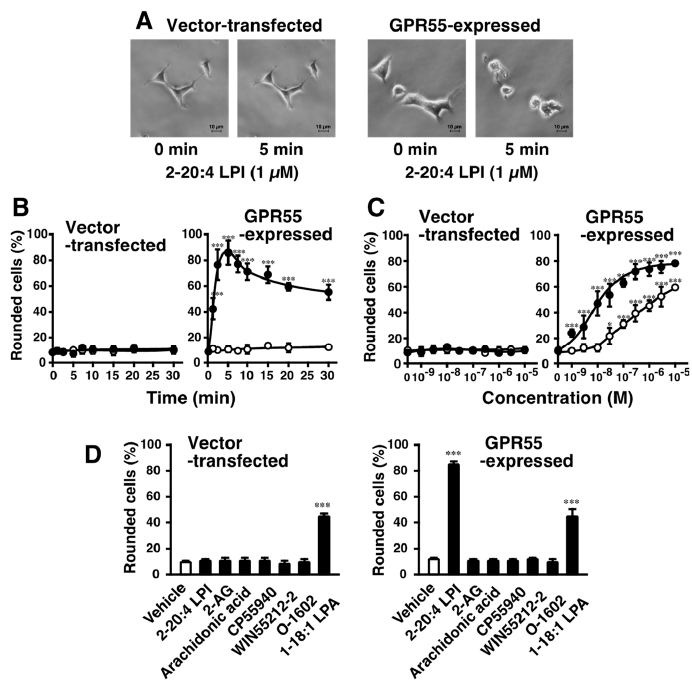
Figure 1. Effects of 2-arachidonoyl LPI on cell rounding of GPR55-expressing HEK293 cells. ( A ) Morphological changes induced by 2-arachidonoyl LPI. Vector-transfected cells (left) or GPR55-expressing cells (right) were challenged with 2-arachidonoyl LPI (1 µM) at 37 °C for 0 or 5 min. Scale bar, 10 μ m. The results are representative of three independent experiments, which gave similar results. ( B ) Time course of cell rounding. Vector-transfected cells (left) or GPR55-expressing cells (right) were treated with the vehicle (DMSO; open circles) or 2-arachidonoyl LPI (1 µM; closed cir- cles) at 37 °C for the indicated periods. ( C ) Dose-dependent effects of LPI on cell rounding. Vector- transfected cells (left) or GPR55-expressing cells (right) were treated with the indicated concentra- tions of 1-stearoyl LPI (closed circles) or 2-arachidonoyl LPI (closed circles) at 37 °C for 5 min. ( D ) Effects of various cannabinoids and related compounds. Vector-transfected cells (left) or GPR55- expressing cells (right) were treated with the indicated compounds (1 µM) at 37 °C for 5 min. After treatment, images of cells were obtained, and cell rounding was analyzed. Statistical analyses were performed with one-way analysis of variance (ANOVA), followed by Dunnett’s multiple compari- son test ( B ) or Tukey–Kramer multiple comparison test ( C , D ). The values are means ±SDs of five determinations. * p < 0.05, *** p < 0.001 versus values at 0 min ( B ) and versus control values obtained with 0 nM LPI ( C , D ). 2-Arachidonoyl LPI-induced cell rounding was dependent on the concentration of LPI (Figure 1C, right). Even a high concentration of 2-arachidonoyl LPI did not induce the rounding of empty-vector-transfected cells (Figure 1C, left). The potencies of various molecular species of LPI markedly differed (Figures 1C and 2A–C). The highest level of activity was observed with 2-arachidonoyl(20:4) LPI (Figure 1C, right) at an EC 50 of 10 nM. Its activity was approximately 30-fold stronger than that of 1-stearoyl(18:0) LPI at an EC 50 of 300 nM (Figure 1C, right). The rank order of potency was 2-arachidonoyl(20:4) > 2-linoleoyl(18:2) = 2-oleoyl(18:1) > 1-oleoyl(18:1)> 1-linoleoyl(18:2) > 1-stearoyl(18:0) = 1-palmitoyl(16:0). The maximal effects of 1-acyl LPIs (1-palmitoyl, 1- stearoyl, 1-linoleoyl, and 1-oleoyl LPIs) were weaker than those of 2-acyl LPIs, including 2-arachidonoyl LPI, suggesting that 1-acyl LPIs acted as a weak partial agonist (Figures 1C and 2A–E).